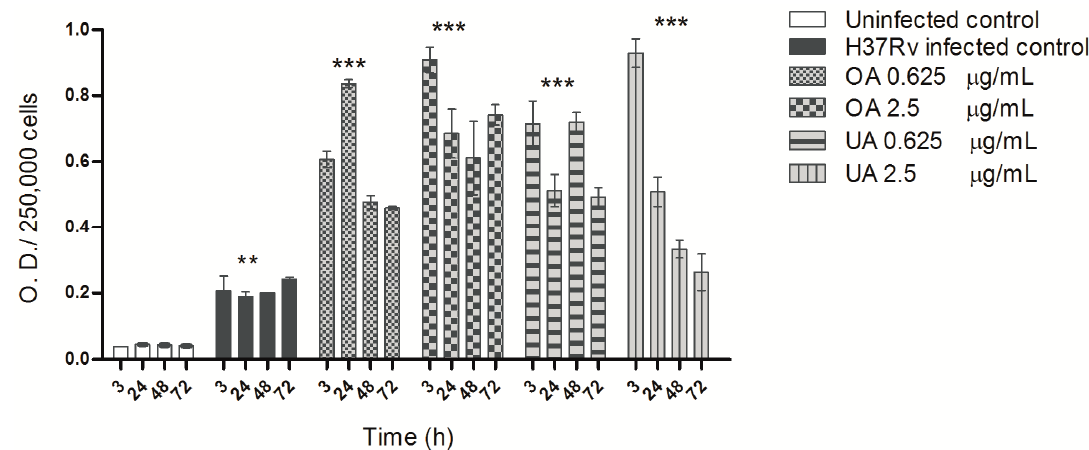
Figure 3. Enhancement of ROS production by triterpenes in MTB infected